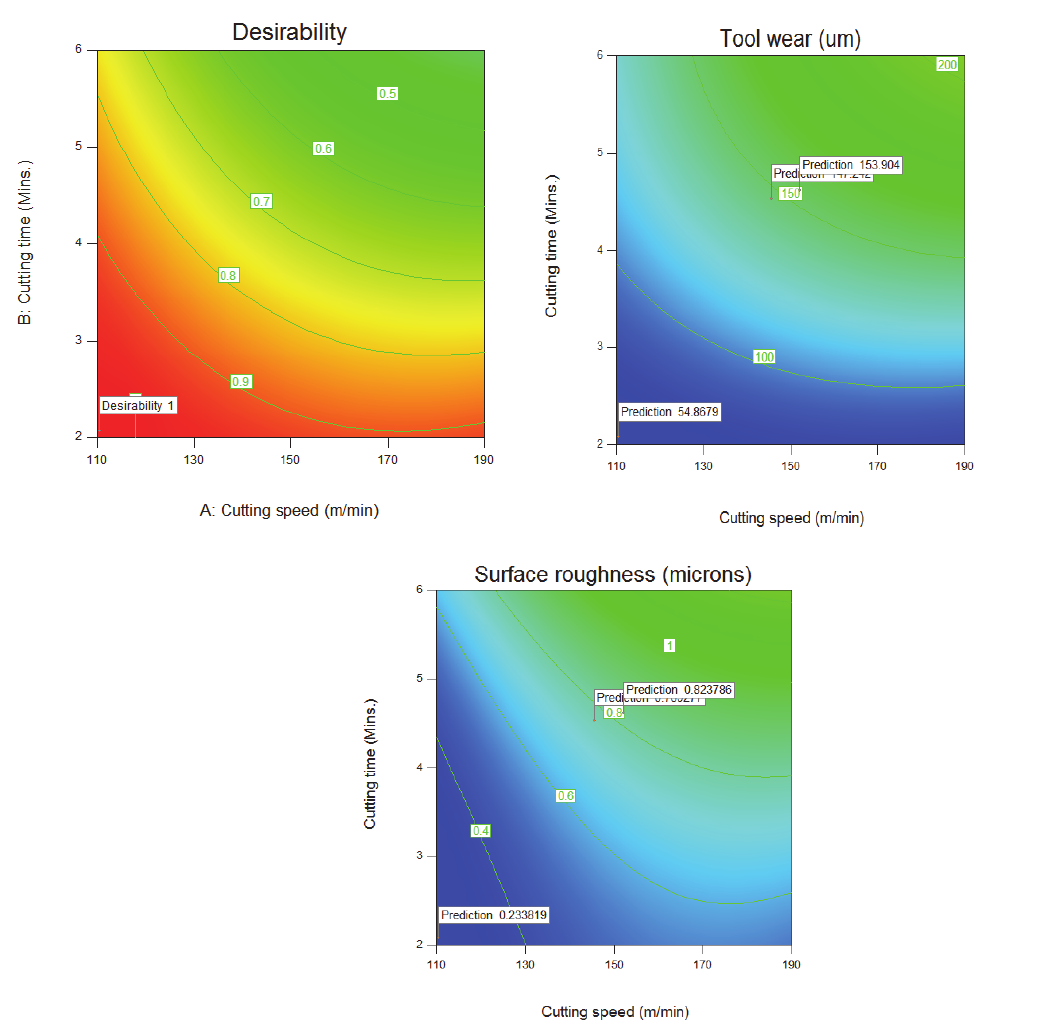
Fig. 9 . Composite desirability for tool wear and surface